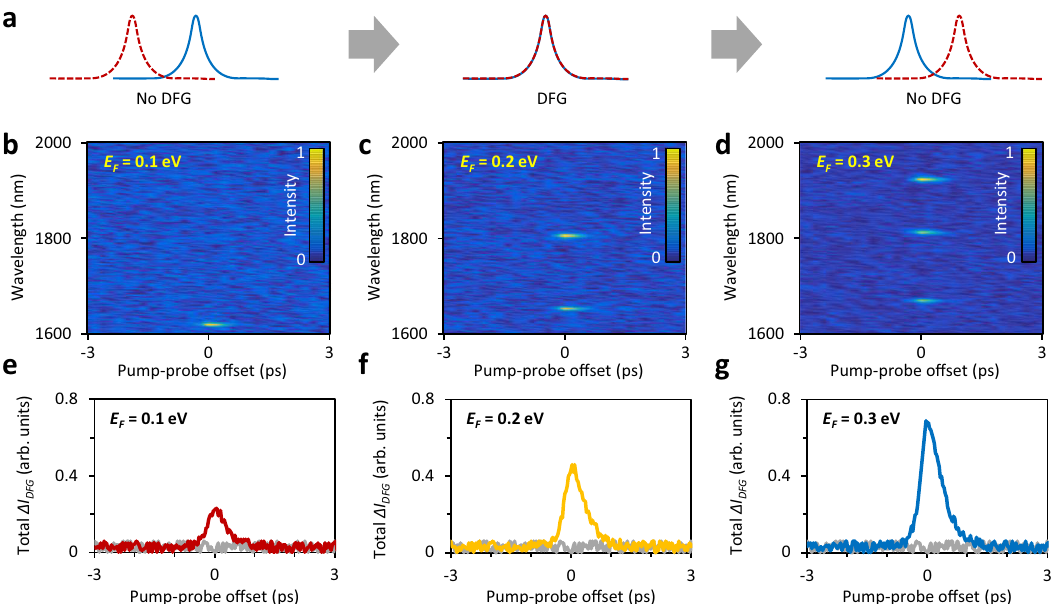
Fig. 3 Time-correlation measurements of the plasmon generation via DFG. a Sketch of the time-correlation experiment, DFG occurs only when the pump and the probe overlap in time. b – d The Δ I DFG maps corresponding to different f sp , when the graphene ’ s Fermi level is 0.1, 0.2 and 0.3 eV. Colour bar: normalized intensity. e – g The total Δ I DFG traces, when the graphene ’ s Fermi level is 0.1, 0.2 and 0.3 eV. The grey curves show the reference signal (background) when f pump − f probe is far from the plasmonic